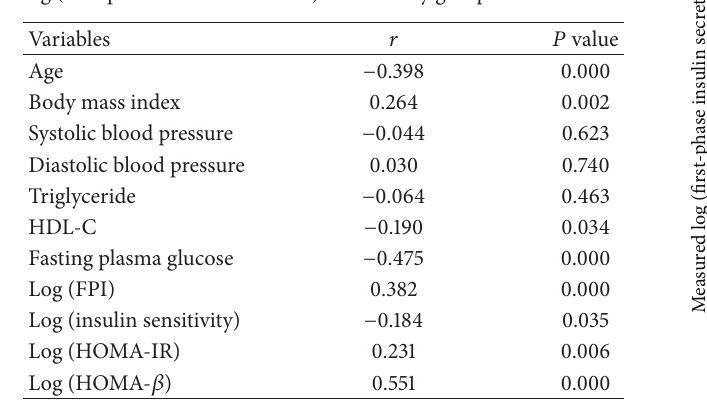
Figure 1: The correlation between the calculated first-phase insulin secretion and measured first-phase insulin secretion by using metabolic syndrome components in the external validation group.